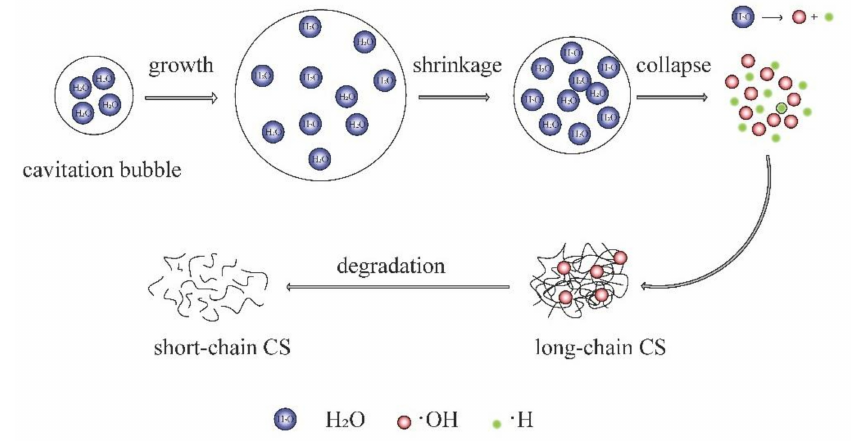
Figure 10. The processes of the formation of · OH and the degradation of